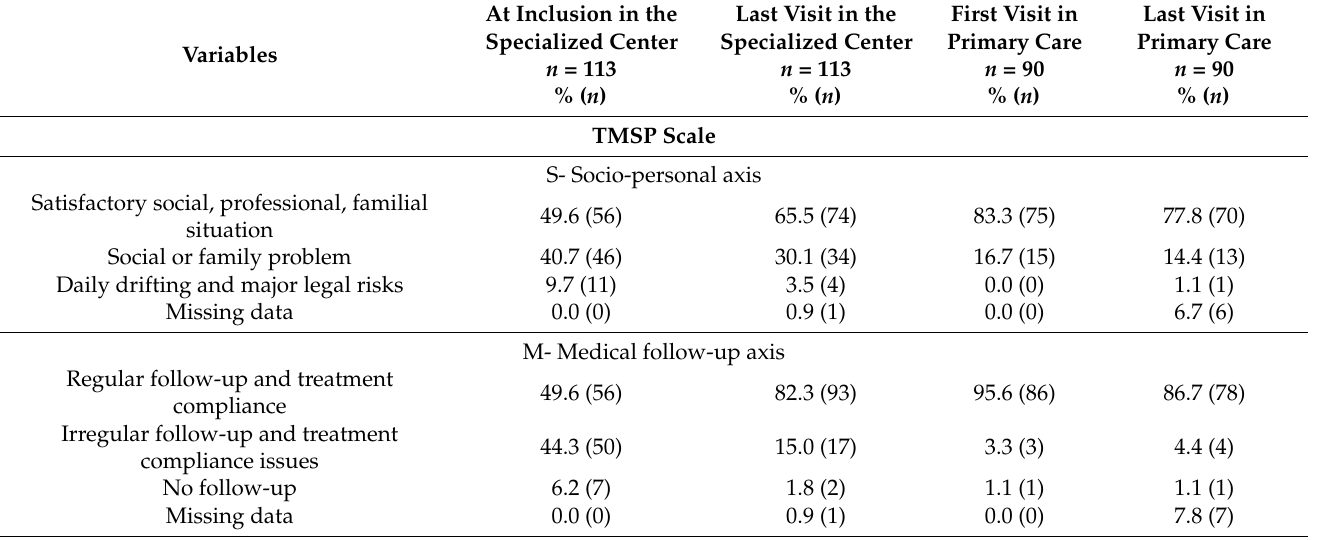
Table 2. Severity and quality of life at the four main transition times in the overall follow-up (entry into specialized care and last visit, entry into primary care and last